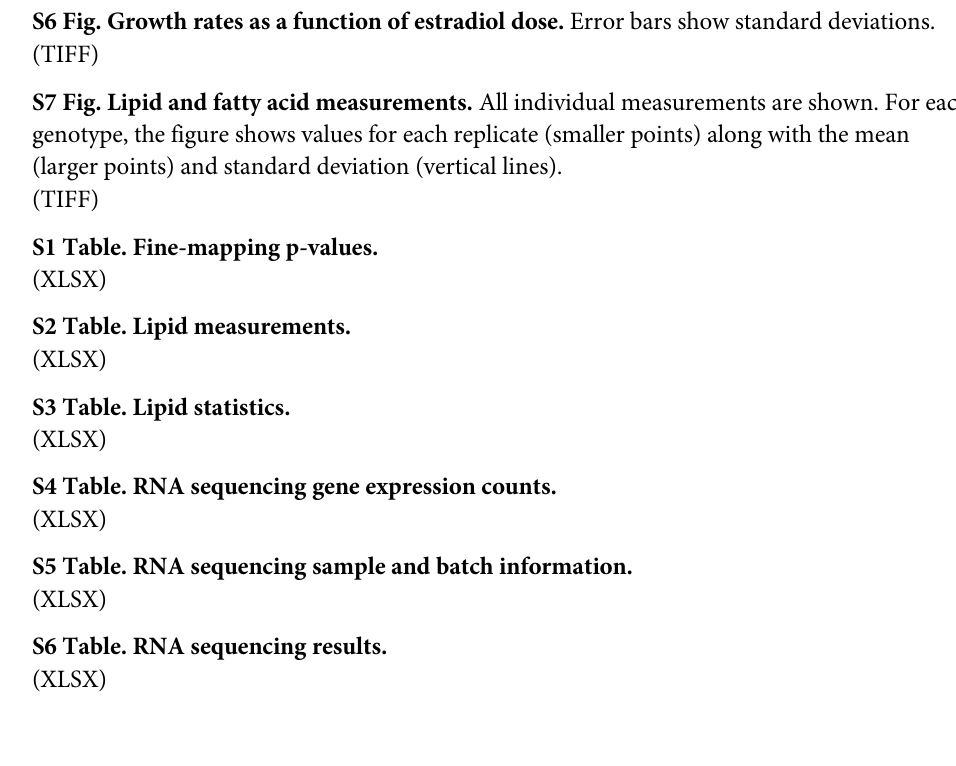
S3 Fig. OLE1 fine mapping. On the left are schematics of OLE1 alleles with BY sequences in blue and RM sequences in red. Only the one missense variant and none of the synonymous variants in the open reading frame are marked. Variants in the non-coding region are maked with a single line for a SNV and a two diagonal lines for INDELs. On the right are the corre- sponding Faa4-GFP fluorescence levels for each allele. P-values are for tests comparing each allele to its respective wildtype. Significant p-values are outlined. Blue boxplots indicate alleles in the BY background and red boxplots and background gray shading indicate alleles in the RM background. Lines group measurements of the same clone. Different symbols (circles, squares, etc.) denote different plate reader runs. S4 Fig. yeVenus reporter expression. On the top are schematics of the SDS23/OLE1 locus and the two orientations of the yeVenus reporter constructs. The bottom panel shows yeVenus fluorescence levels for the indicated yeVenus reporter constructs. Blue boxplots indicate alleles in the BY background and red boxplots indicate alleles in the RM background. Lines group measurements of the same clone. Different symbols (circles, squares, etc.) denote different plate reader runs. S5 Fig. Effects of plasmid overexpression of SDS23/OLE1 sequences on Faa4-GFP expres- sion. Faa4-GFP fluorescence levels of strains transformed with a LEU2 -CEN plasmid contain- ing the indicated sequence. Lines group measurements of the same clone. S6 Fig. Growth rates as a function of estradiol dose. Error bars show standard deviations. S7 Fig. Lipid and fatty acid measurements. All individual measurements are shown. For each genotype, the figure shows values for each replicate (smaller points) along with the mean (larger points) and standard deviation (vertical lines). S1 Table. Fine-mapping p-values. S2 Table. Lipid measurements. S3 Table. Lipid statistics. S4 Table. RNA sequencing gene expression counts. S5 Table. RNA sequencing sample and batch information. S6 Table. RNA sequencing